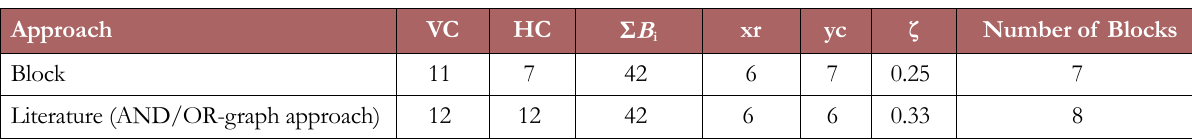
Table 4. Complexity Index for Instance 5